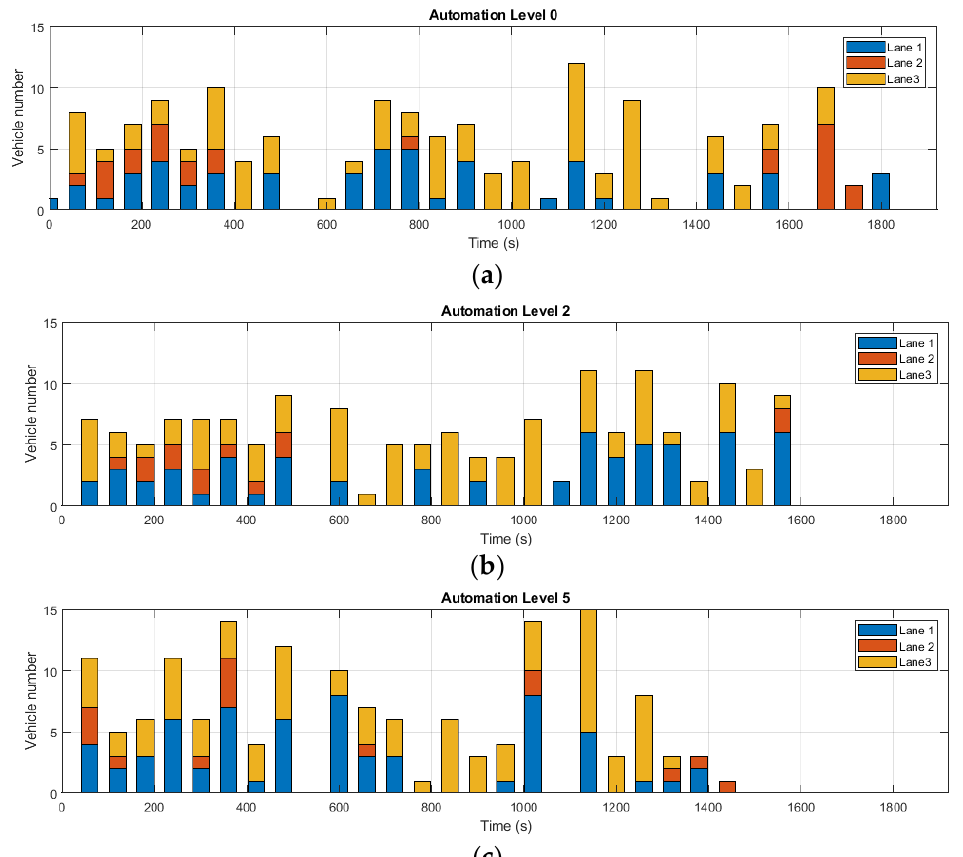
Figure 6. ( a–c ) Comparison of simulations with different driver models. Figure 6. ( a – c ) Comparison of simulations with different driver